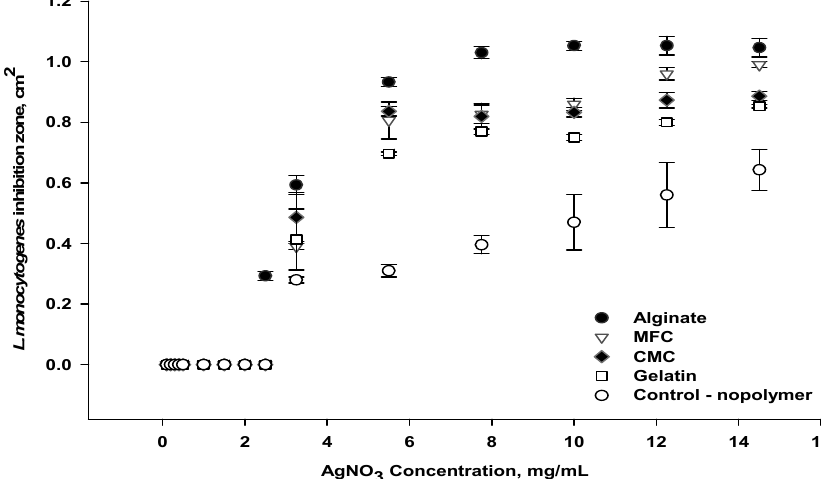
Figure 2. Antimicrobial activity of coated paper using silver and different polymers .